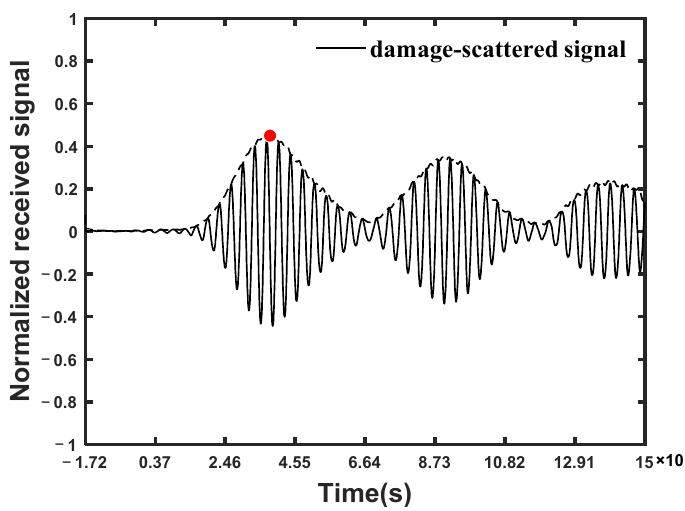
Figure 6. The damage-scattered signal with envelope curve received from the sensing path AB.